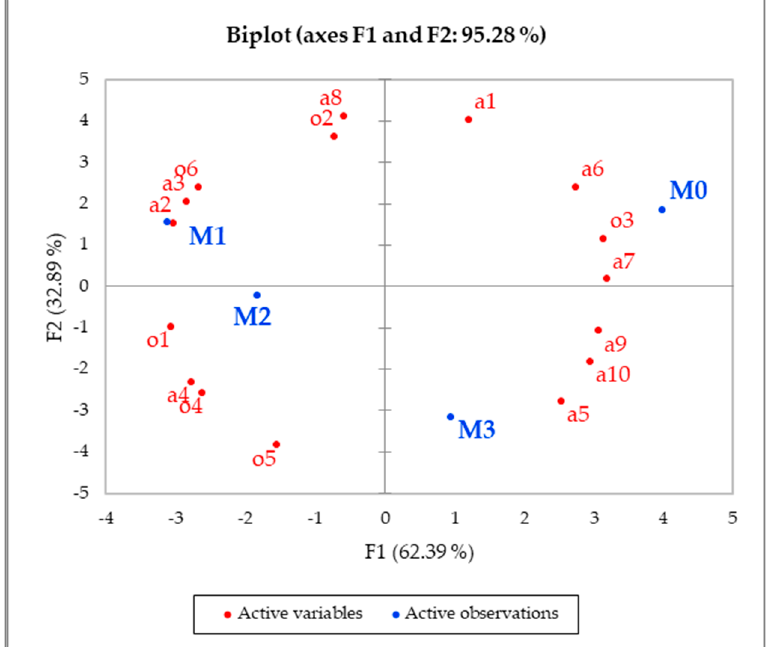
Figure 2. Principal component analysis of meat packages (M0, M1, M2, and M3) showing correlations with sensory attributes (codes on plot refer to sensory attributes codes in Table 3).